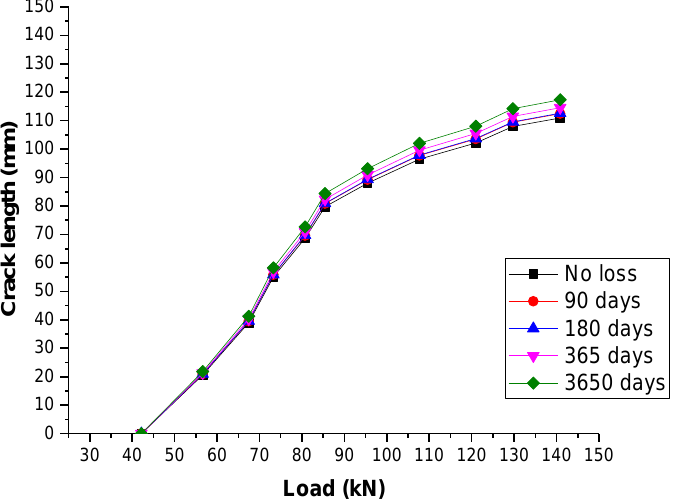
Figure 9. Effect of relaxation in terms of load-crack length response.